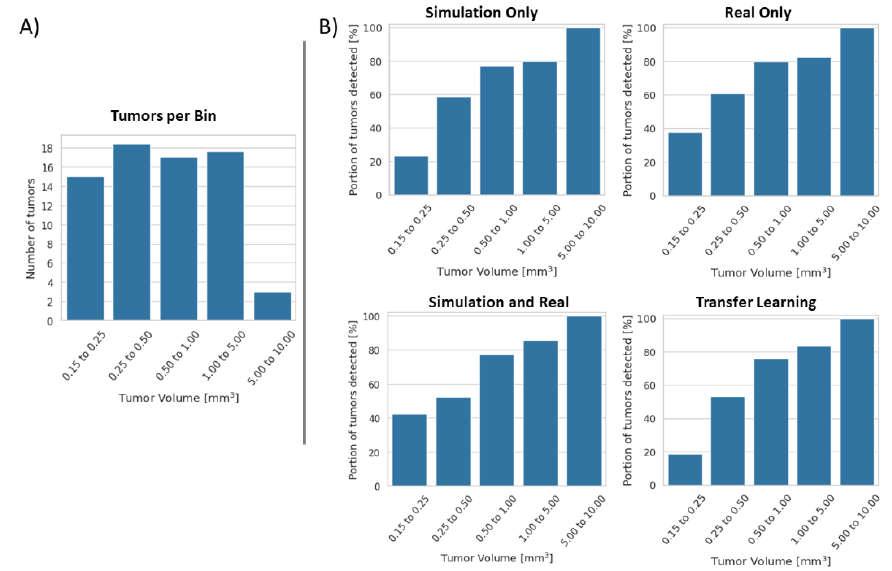
Figure 8. Distribution of tumor sizes and detection rates in experimental data. ( A ) Most tumors fell